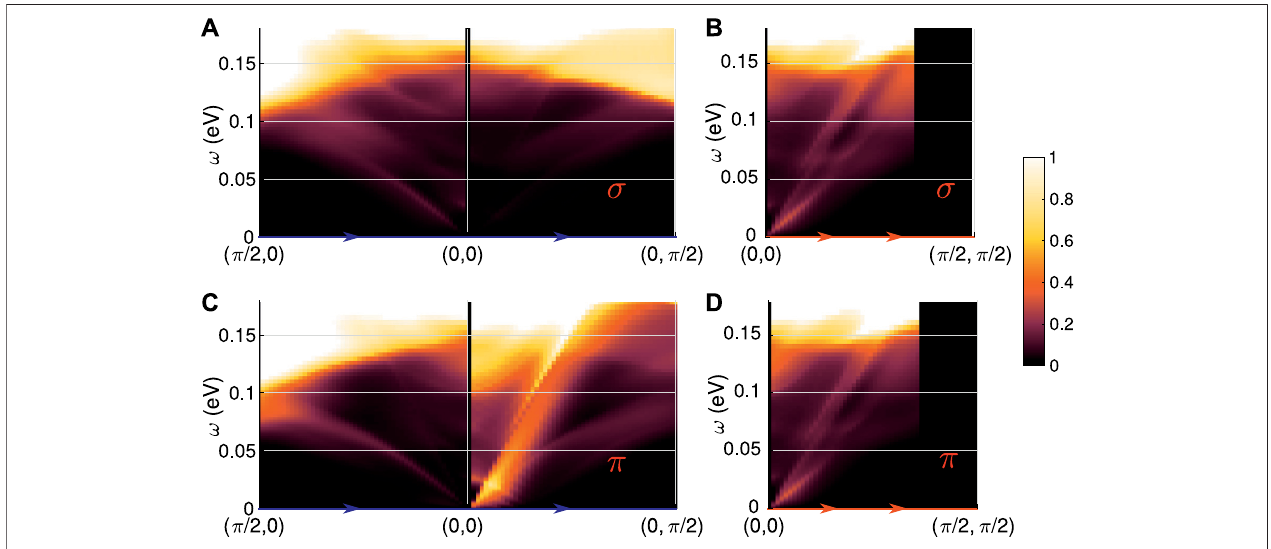
FIGURE 4 | Polarization dependence of RIXS intensity. Expected RIXS spectra decomposed in the intensities from σ (A,B) and π polarization of the outgoing photons (C,D) along the paths de fi ned in Figure 3B ; U = 0.57 eV, J = U /6.